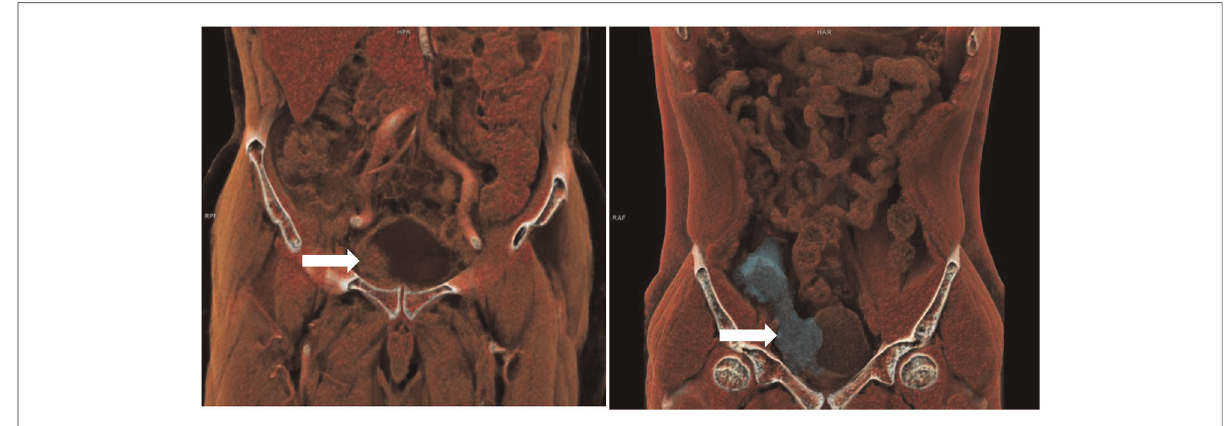
FIGURE 1 Three dimensional reconstructive CT of two patients with bladder invasion after right inguinal hernia